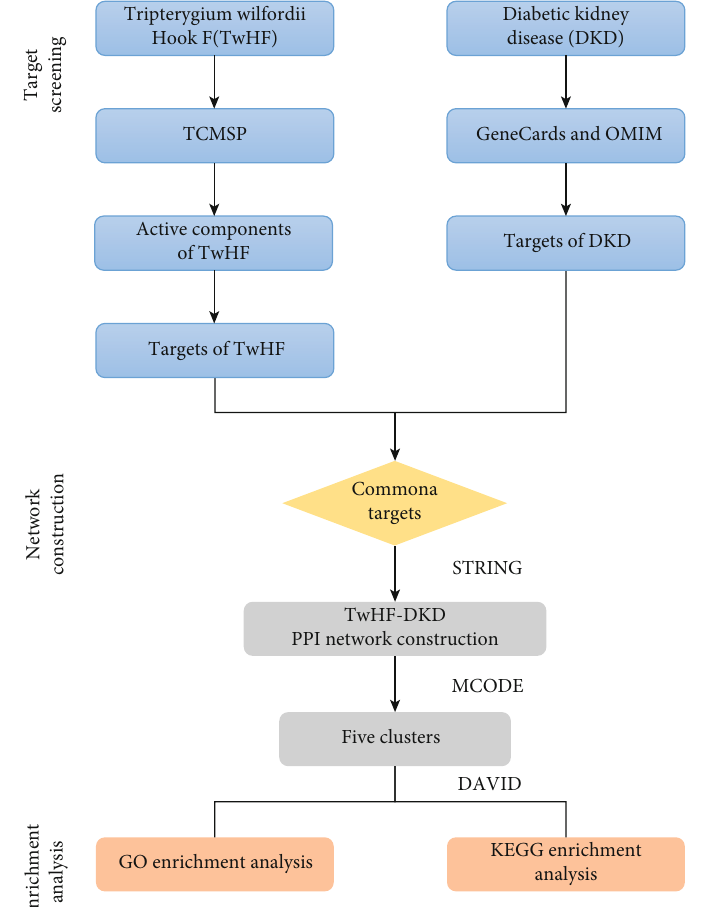
Figure 1: The whole framework for TwHF against